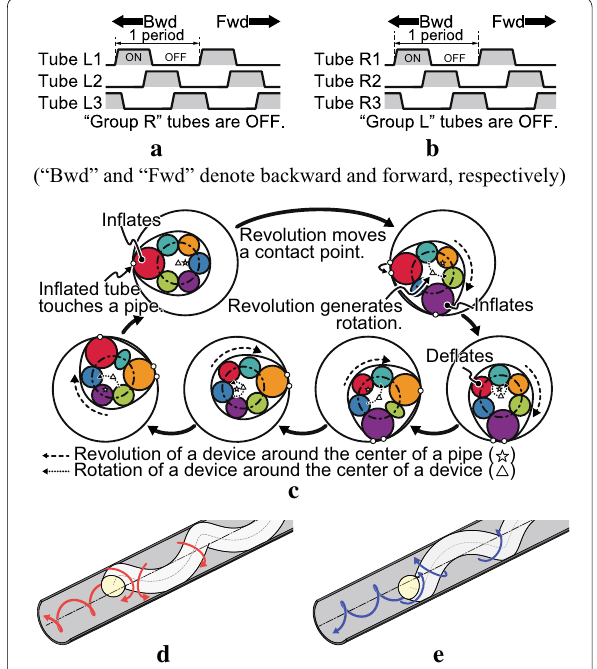
Fig. 2 Motion of six braided-tube device in the case of driving only one group. Periodical pressurizations generate a revolution of a device around a center of a pipe and a rotation of a device around a center of a device. a and b Pressurization patterns for Group L and R tube propulsion, respectively. c is a motion of the device tip with Group L pressurization. d and e Motions driven by Group L and R tubes. The devices form left- and right-handed helices, which generates a right- and left-handed trajectories,